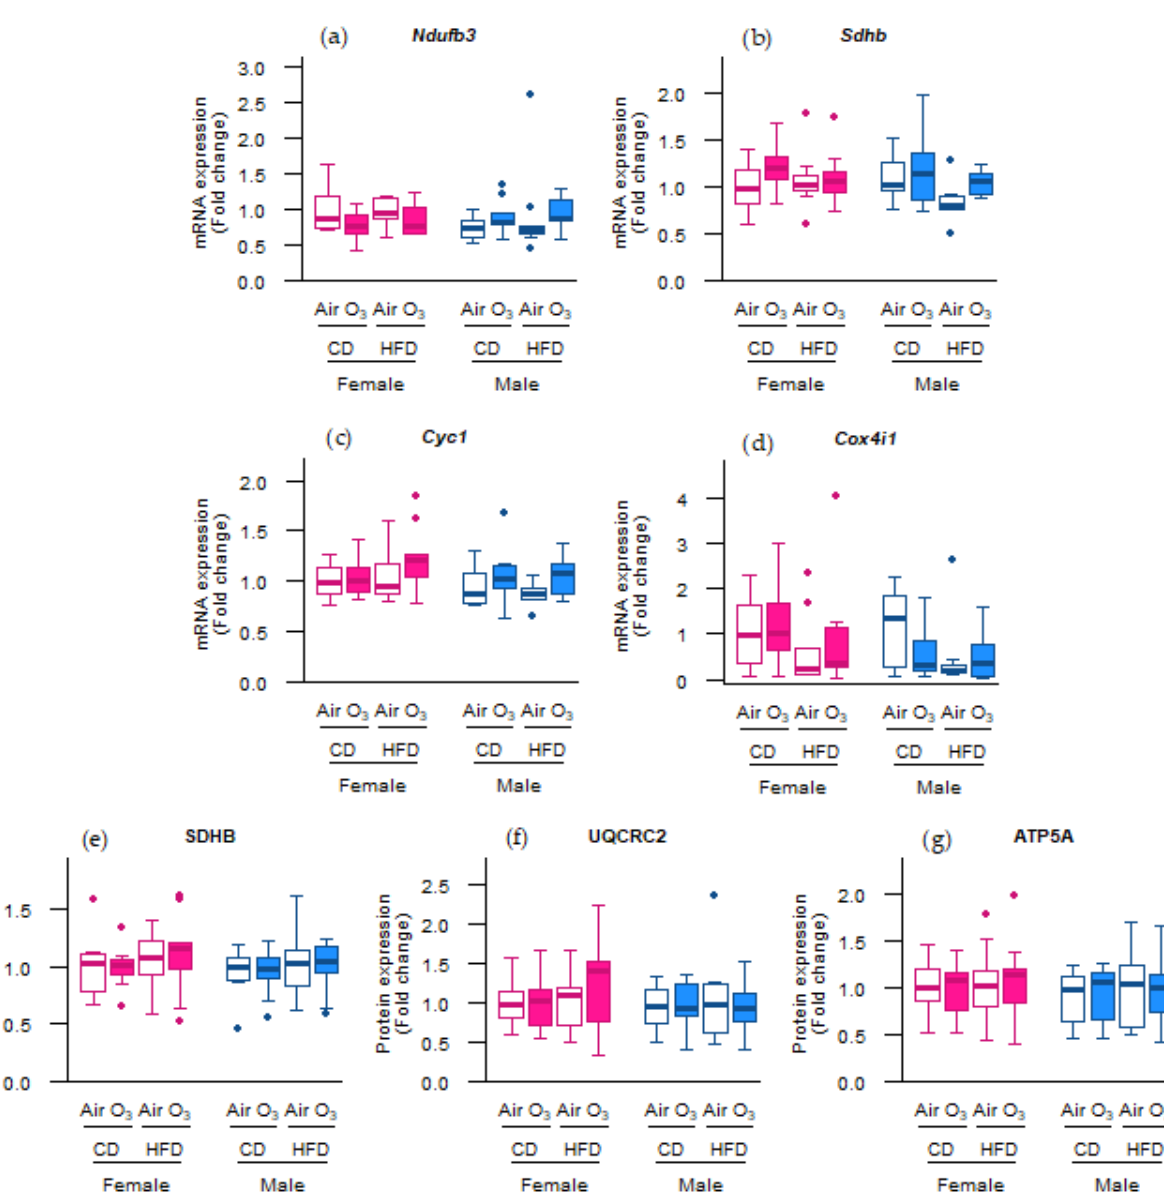
Figure 4. Perinatal high-fat diet (HFD) or acute ozone exposure did not change the pulmonary expression of oxidative phosphorylation machinery subunits. mRNA expression of ( a ) Ndufb3 (complex I), ( b ) Sdhb (complex II), ( c ) Cyc1 (complex III), and ( d ) Cox4i1 (complex IV), and the protein expression of ( e ) SDHB (complex II), ( f ) UQCR2 (complex III), and ( g ) ATP5A (complex V) were assessed within two hours after exposure to filtered air or ozone in the lungs of female and male offspring from dams fed a perinatal control diet (CD) or HFD. Data are presented as boxplots. Statistical analysis by two-way ANOVA with Holm–Sidak post-hoc test. n = 9–10 per group ( a – d ) or n = 7–10 per group ( e – g ). O 3